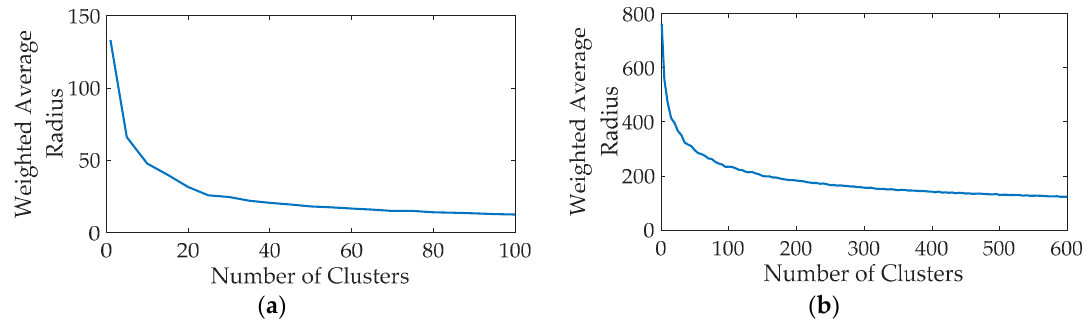
Figure 11. Relation curves between weighted average radius and number of clusters. ( a ) Modified